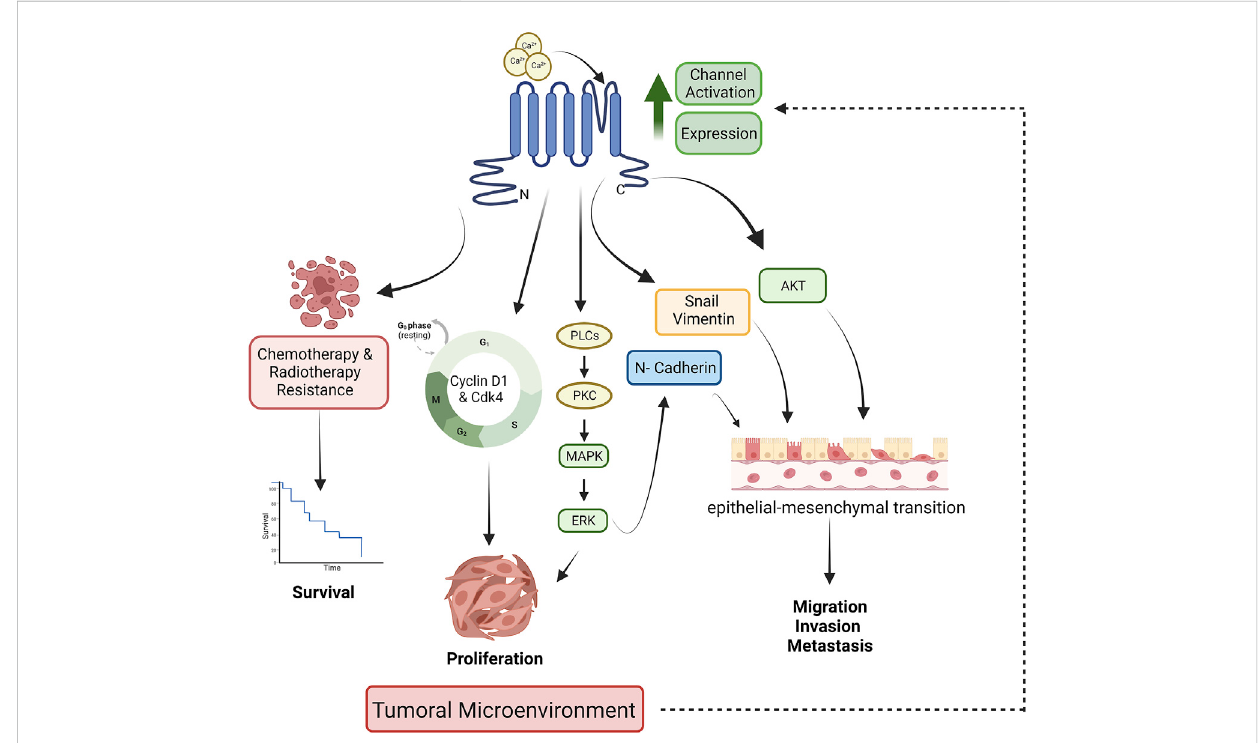
FIGURE 1 TRPM8-dependent mechanisms involved in tumor development. The tumoral microenvironment releases factors that increase the expression and activation of TRPM8 channels. Channel activation leads to the activation of signaling pathways whose activation decreases patient survival and increases proliferation, migration, invasiveness, and metastasis. Designed with